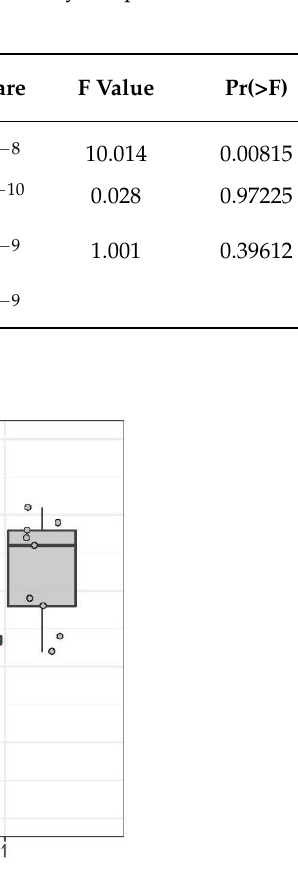
Figure 2. Boxplot of the mean of total lipids extracted from Pinot noir wines produced at two different fermentation temperatures (16 °C and 27 °C) and three yeast product concentrations (0 g/L, 0.5 g/L, and 1 g/L).